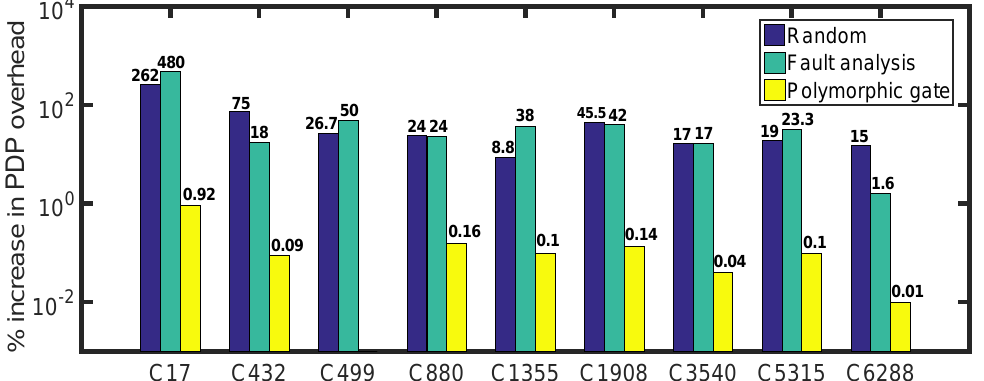
Figure 8. Power-delay product overhead of random, fault analysis and polymorphic gate based logic